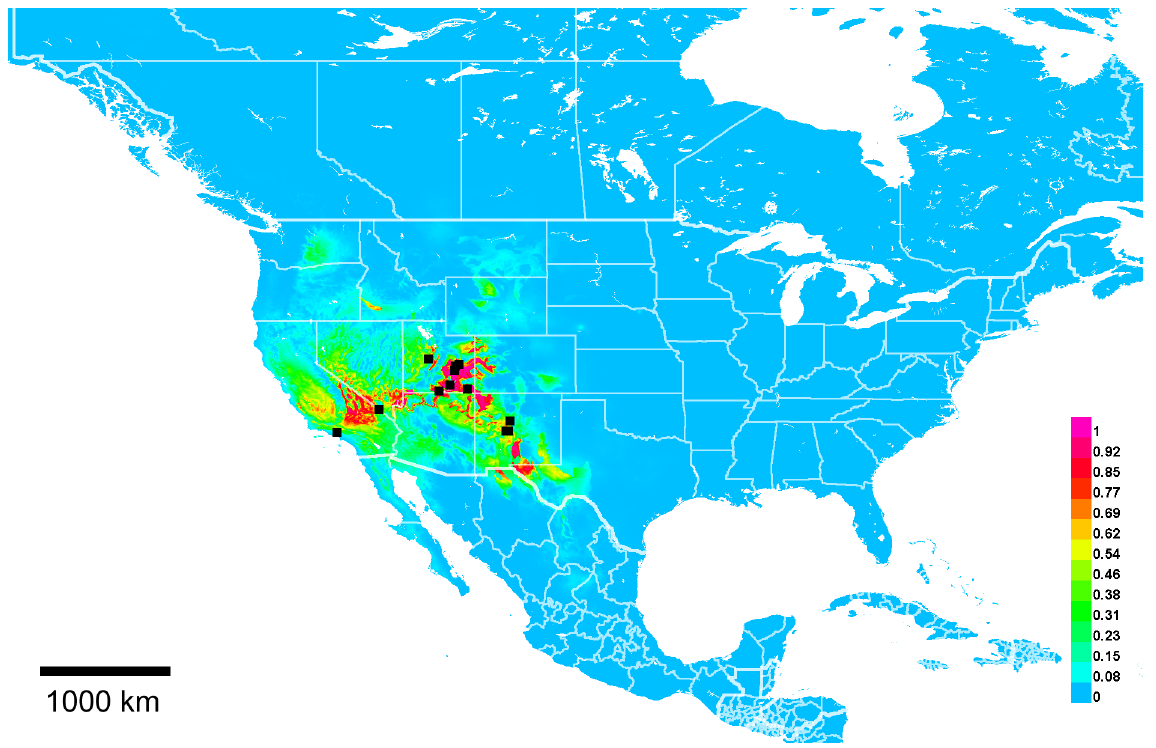
Fig. 29. Georeferenced collection records of Lasioglossum ( D .) gloriosum sp. nov. (black squares) and predicted distribution by maximum entropy ecological niche modelling in Maxent (colour shading). Warmer colours indicate higher cloglog probability of